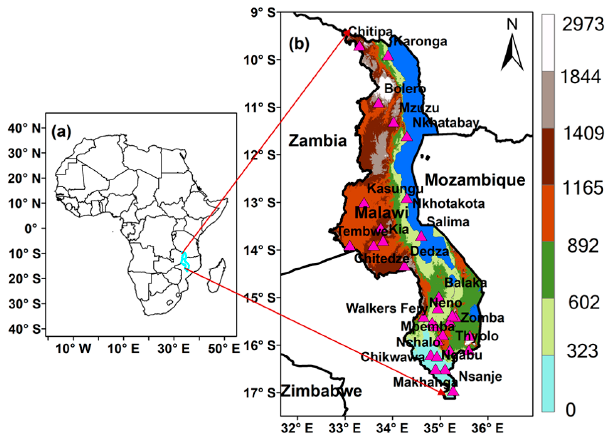
Figure 1. ( a ) Study area depicting location of Malawi in Africa. ( b ) Topography (unit: m) of the study area and the rainfall stations used in the study. The blue color stands for the